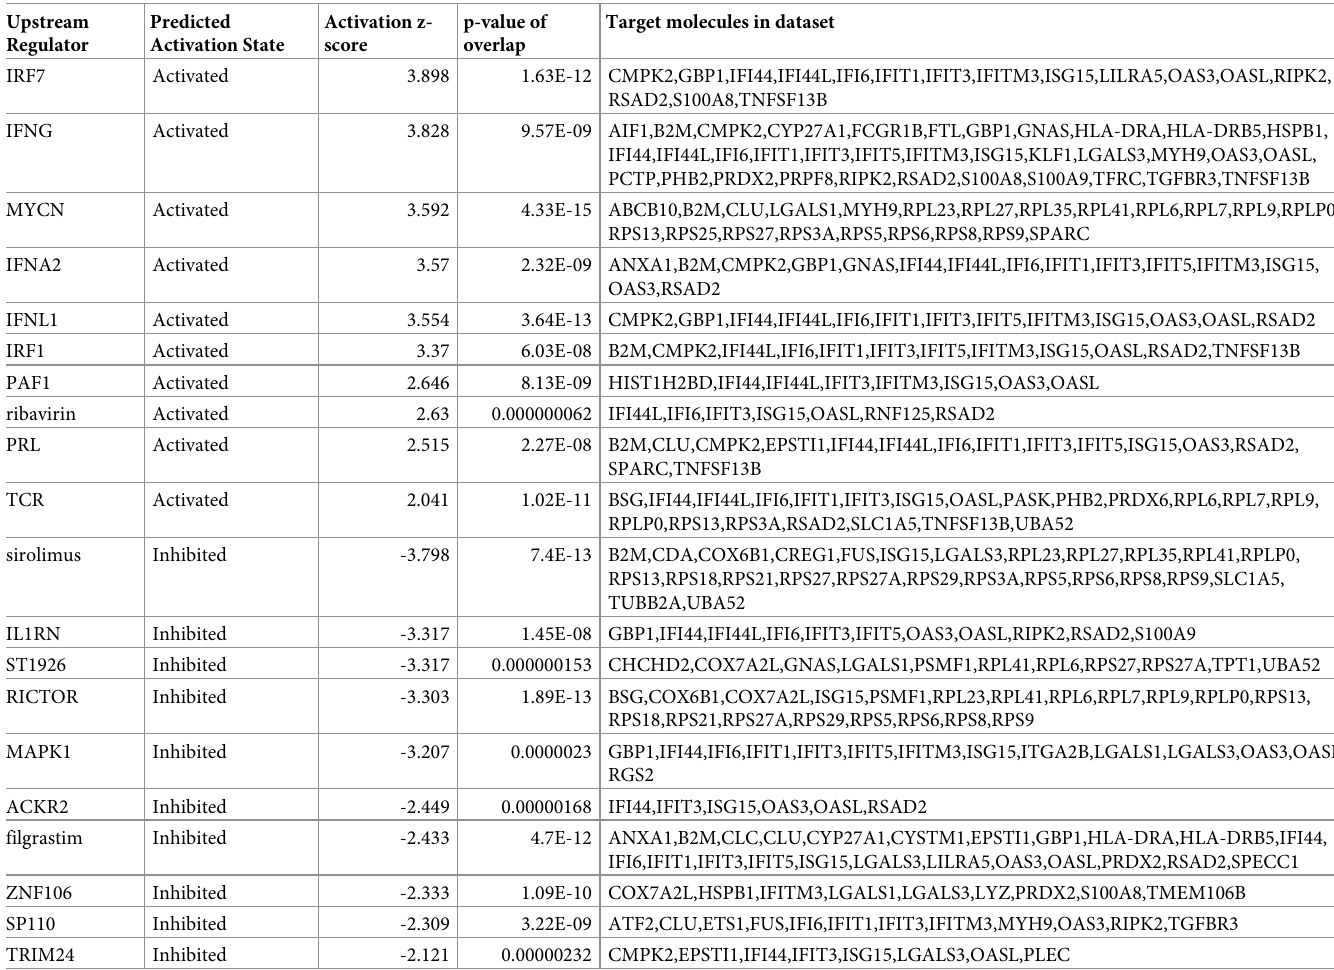
Table 3. A. Top 10 activated upstream regulators identified by pathway analysis for treatment-na ï ve patients compared to healthy controls. B. Top 10 inhibited upstream regulators identified by pathway analysis for treatment-na ï ve patients compared to healthy volunteers. Upstream